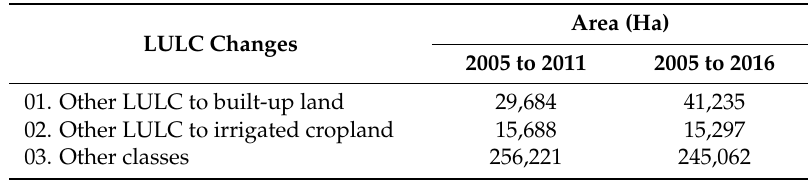
Table 8. Changes in the area (ha) of “other” land-use/land-cover (LULC) to built-up land and irrigated cropland between 2005 and 2011 and between 2005 and 2016.